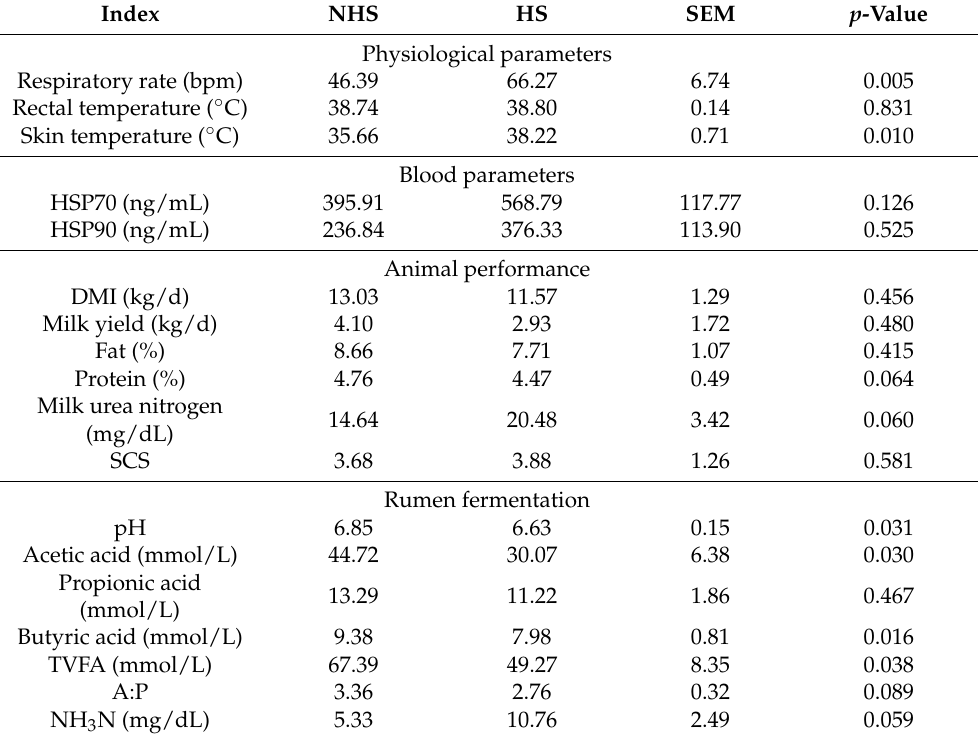
Table 2. Differential response in physiological parameters, blood parameters, animal performance, and rumen fermentation for buffalo under non-heat stress (NHS; n = 6) and heat stress (HS; n = 6) conditions. Index NHS HS SEM p -Value Physiological parameters Respiratory rate